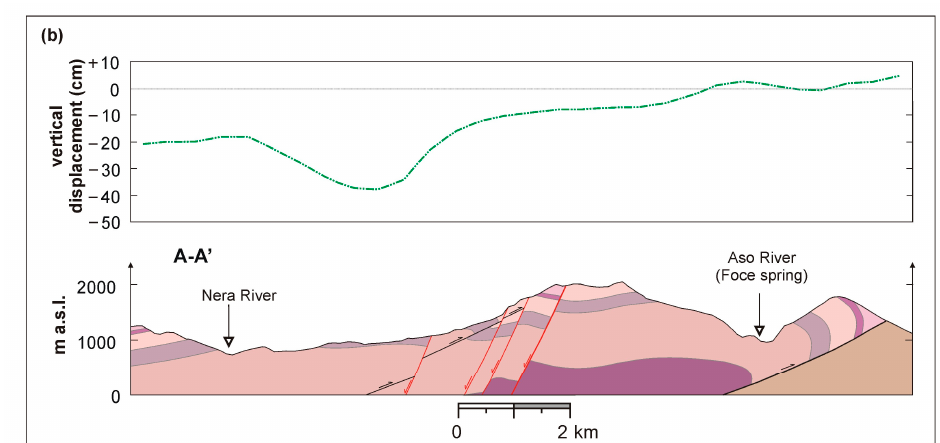
Figure 1. ( a ) Hydrogeological map of the upper part of the Nera River catchment with the mainshocks of 26–30 October 2016, seismic sequence (information on earthquakes are in Table 1).